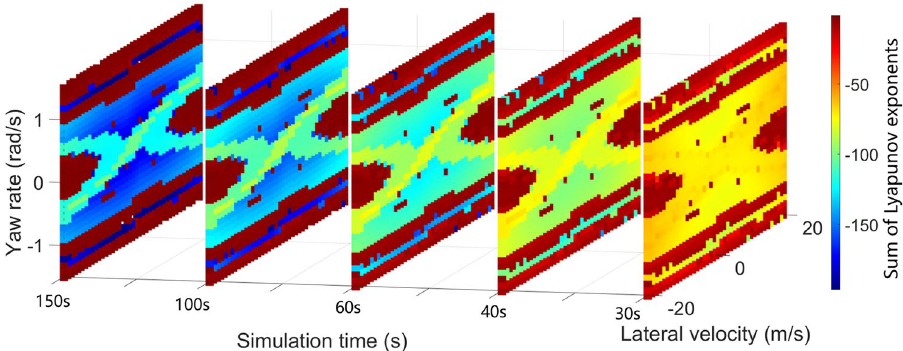
Figure 3. Sum of Lyapunov exponents at different time.